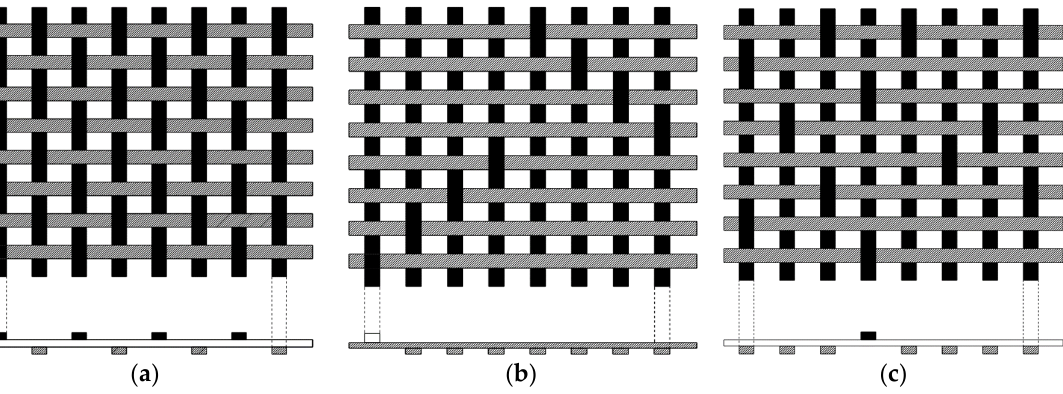
Figure 13. Weaves of carbon fiber ( a ) Plain weave—3K ‐ 70 ‐ P carbon ( b ) 8 ‐ harness satin weave—3K ‐ 135 ‐ 8H carbon ( c ) 5 ‐ harness satin weave—1K ‐ 50 ‐ 5H carbon. Reproduced from [107].